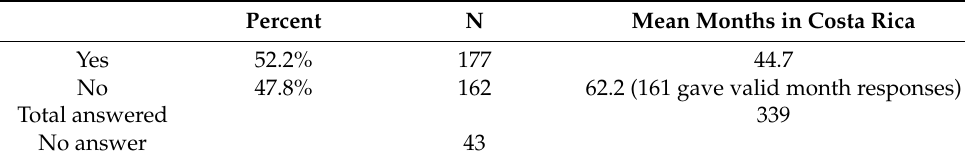
Table 5. Migrants who sent remittances to Nicaragua (data from the 1999 Costa Rica